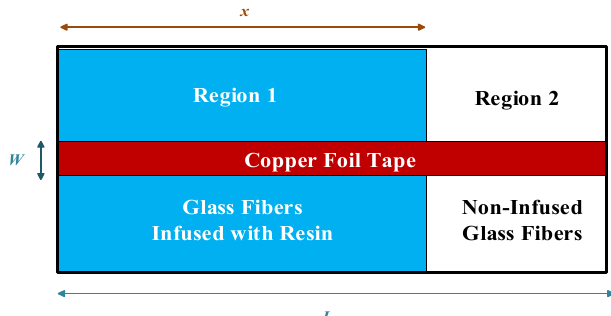
Figure 6. Illustration of top view of mold